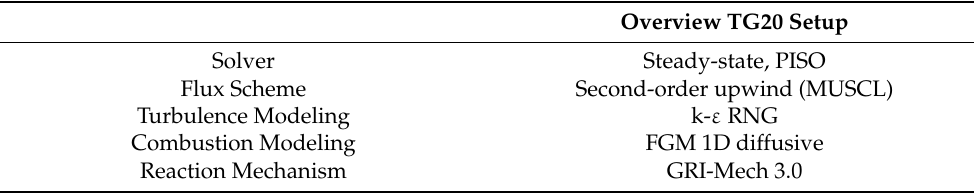
Table 5. Case setup